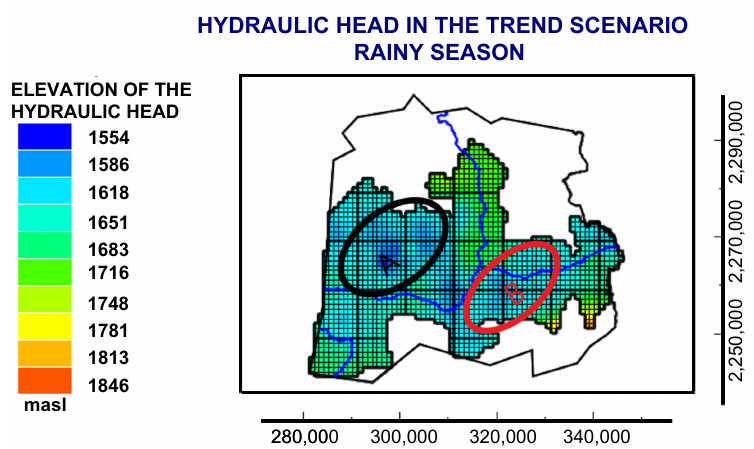
Figure 18. Elevation of the hydraulic head of the year 2030 through the trend scenario in the Figura 3.4: Elevaci´on de la carga hidr´aulica del a˜no 2030 a trav´es del escenario Tendencial en la rainy Temporada de Lluvias.